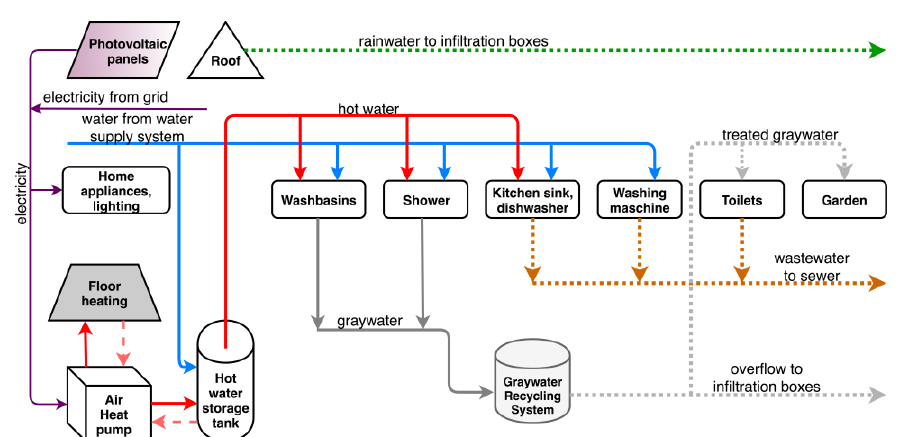
Figure 8. Diagram of system operation in Variant 5.